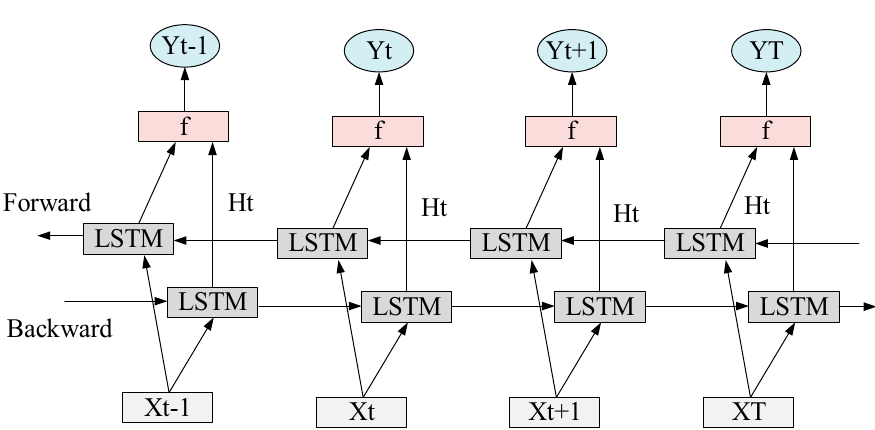
Figure 6. Schematic diagram of the Long Short-Term Memory (LSTM) model